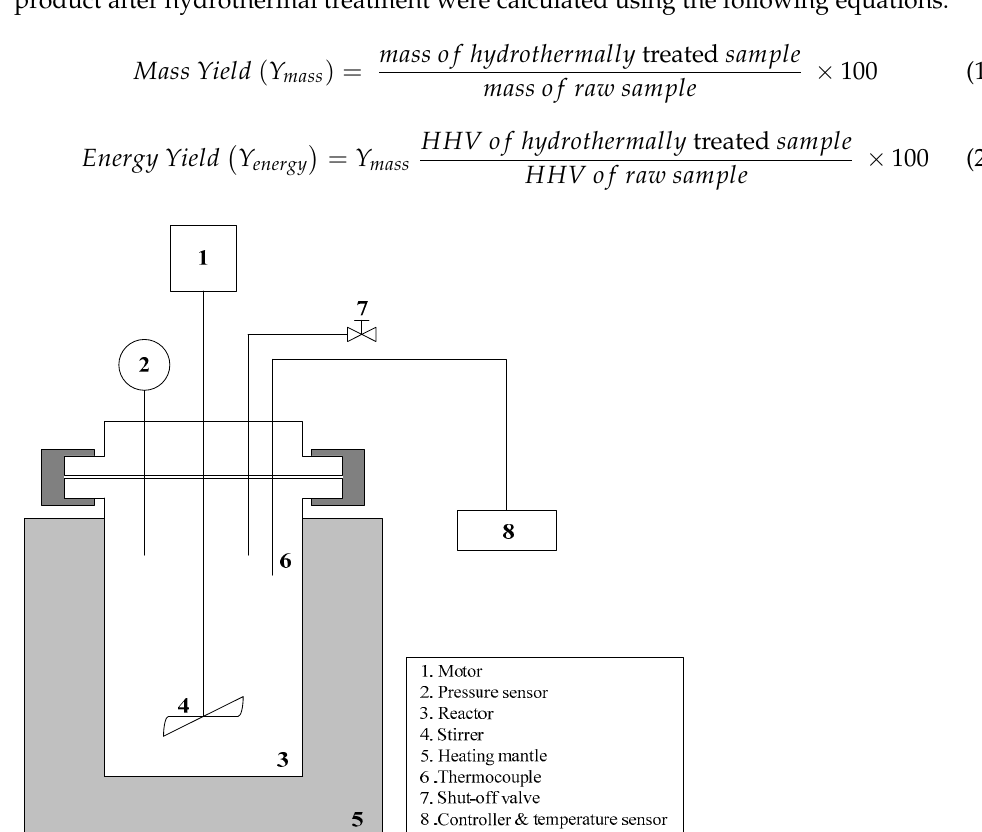
Figure 1. Schematic diagram of the experimental apparatus used in this study.